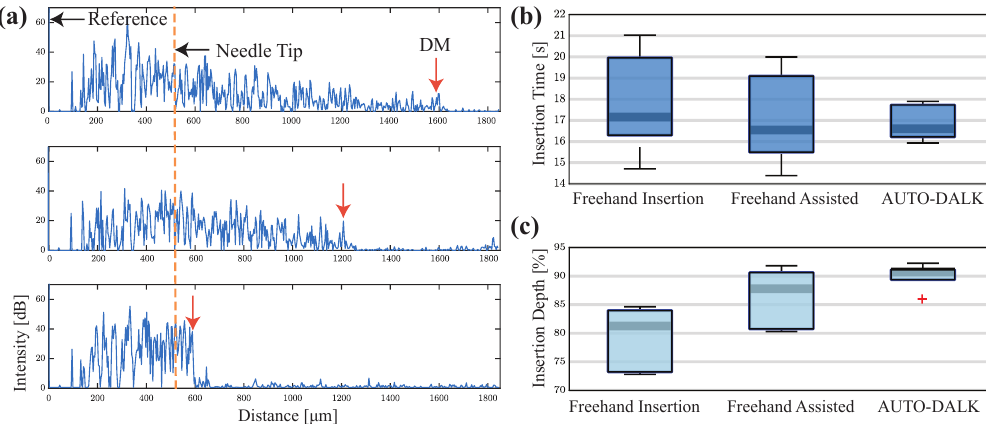
Figure 7. ( a ) A-scan images (inserted at 60 degrees from vertical) of the porcine cornea as the needle advances toward DM. Distance between the needle tip and DM, 1100 µ m ( top ), 700 µ m (middle), and 120 µ m ( bottom ). ( b ) Comparison of the insertion time. ( c ) Comparison of the insertion depth as a percentage of cornea